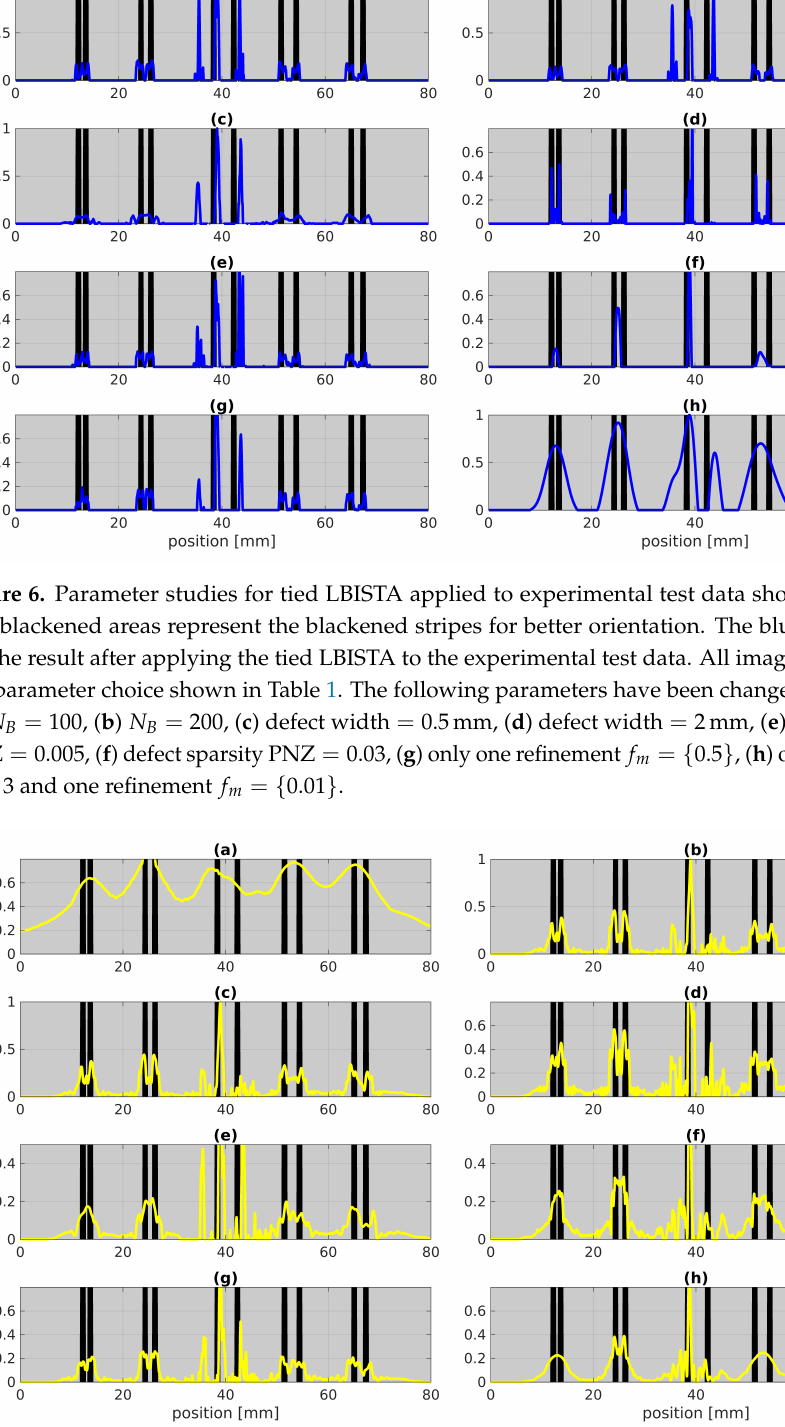
Figure 7. Parameter studies for untied LBISTA applied to experimental test data shown in Figure 3. The blackened areas represent the blackened stripes for better orientation. The yellow curves stand for the result after applying the untied LBISTA to the experimental test data. All images are based on the parameter choice shown in Table 1. The following parameters have been changed, respectively: ( a ) absorption coefficient = { 0.3, 0.7 } , ( b ) Maxiter = 10 5 , ( c ) N B = 100, ( d ) N B = 200, ( e ) defect width = 0.5mm, ( f ) defect width = 2mm, ( g ) defect sparsity PNZ = 0.005, ( h ) defect spar- sity PNZ =